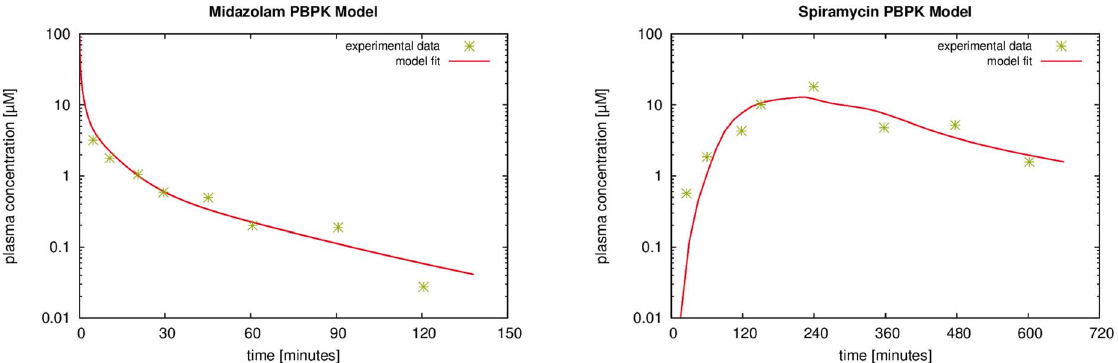
Figure 5. PBPK model establishment and parameter identification. Pharmacokinetic simulations of an intravenous dose of midazolam of 2 : 5mg per kg body weight (left) and an oral dose of spiramycin of 400mg per kg body weight (right) are shown. The PBPK simulations (red lines) were compared to experimental data (green asterisks) for midazolam [66] and spiramycin [67] in mice.